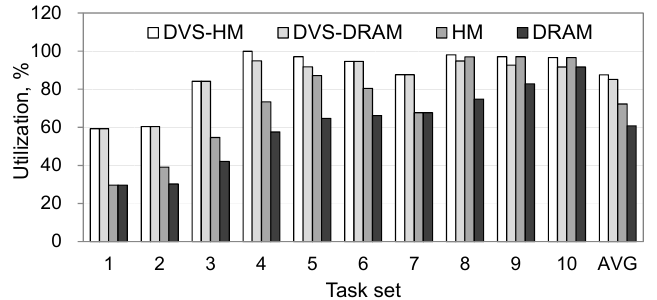
Figure 5. Processor utilizations under synthetic workloads.